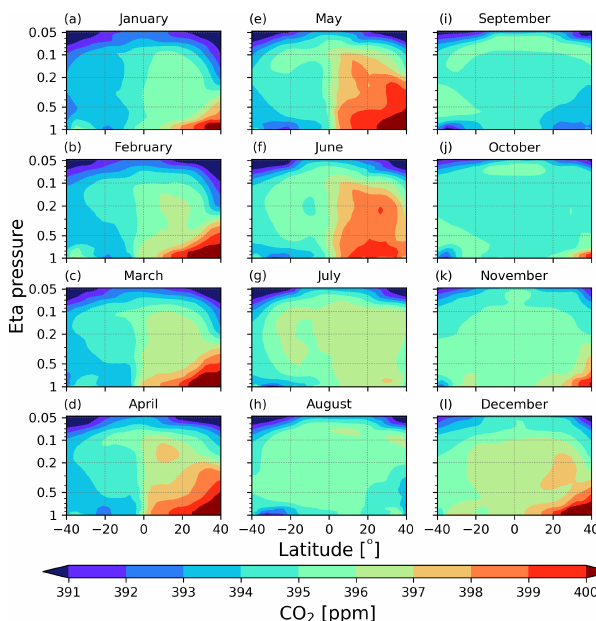
Figure A3. Latitude–pressure distribution of the inversion of the CO 2 mixing ratio at longitude 146 ◦ E in 2015, obtained from ACTM forward simulations.